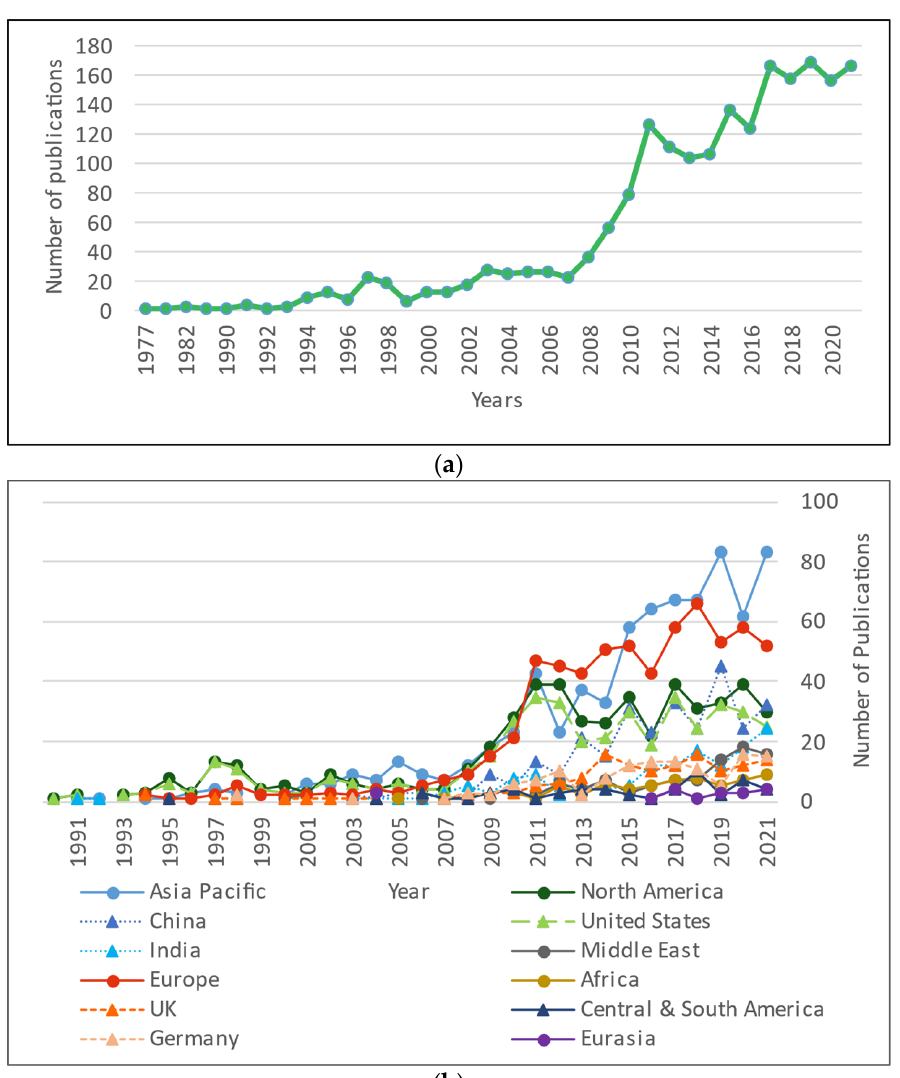
Figure 4. Distribution of documents by ( a ) type of documents ( b ) country/region of publication and in the orange bars publications per million inhabitants.